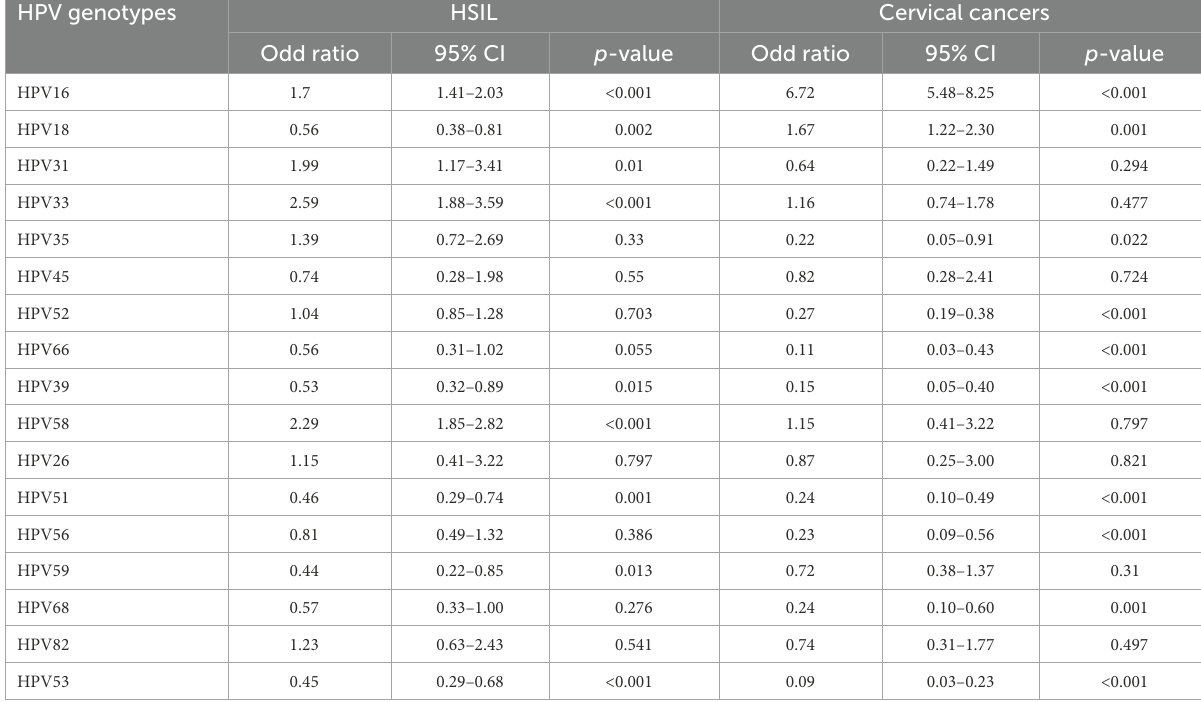
TABLE 6 Odds ratios of high-risk HPV genotypes in HSIL and cervical